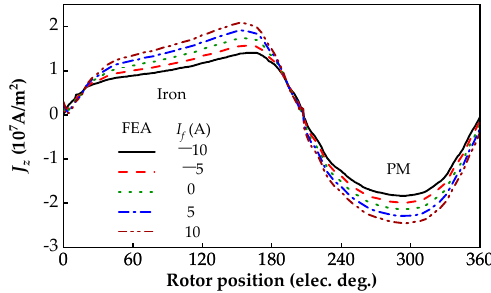
Figure 8. The eddy current densities versus the rotor position.